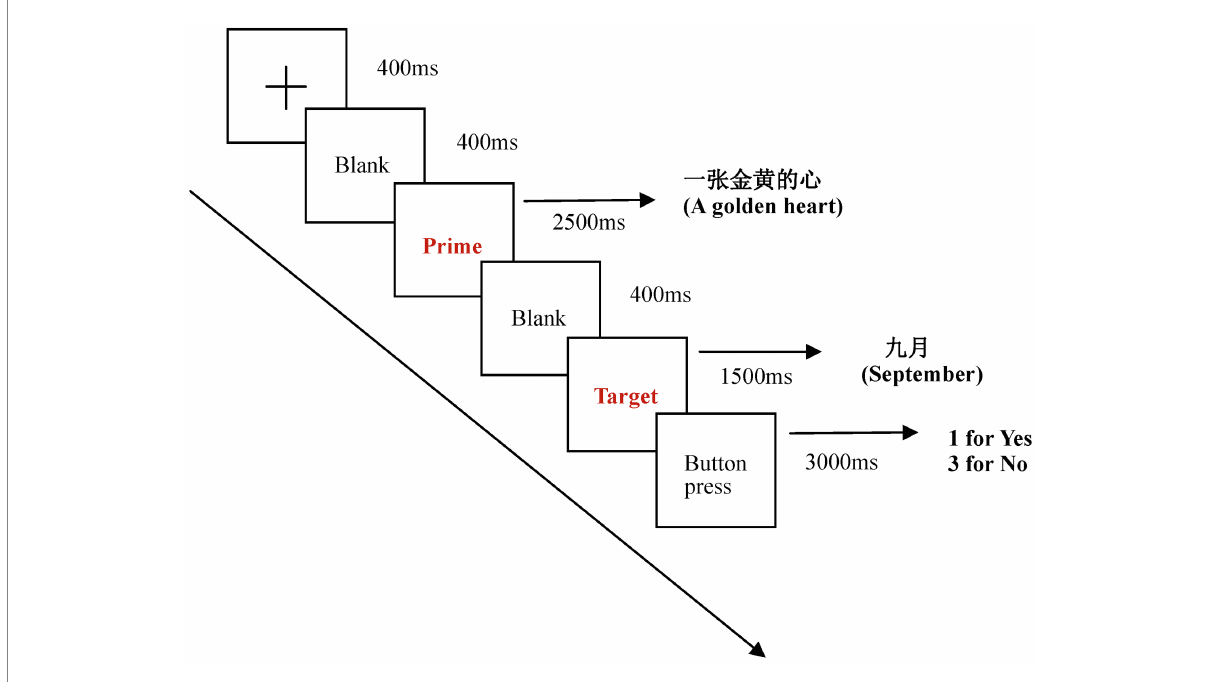
FIGURE 2 Experimental